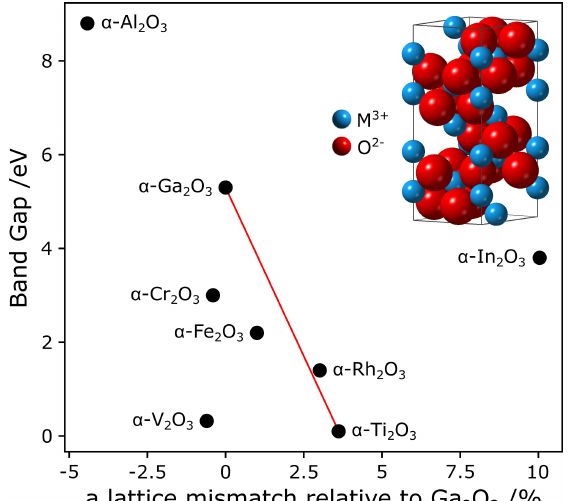
Figure 1. Diagram of the corundum phase semiconducting sesquioxide design space, centered on α -Ga 2 O 3 . The band gaps of the materials [1,27–35] are plotted against their ‘a’ lattice parameters relative to α -Ga 2 O 3 [36–42]. The red line indicates the alloys of α -Ti 2 O 3 and α -Ga 2 O 3 , assuming that the band gap varies linearly with the lattice constants. Inset: Rhombohedral, corundum crystal structure of M 2 O 3 (M: